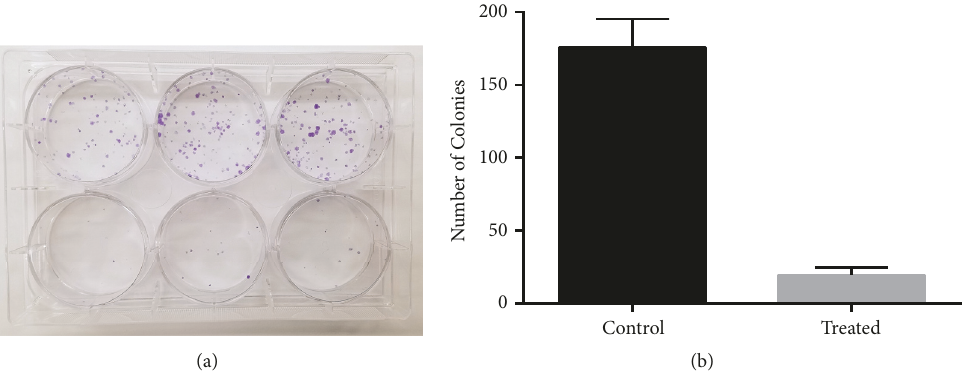
Figure 2: 4,5-diCQA decreases DU-145 cell proliferation after withdrawal of treatment . Clonogenic assays were performed to determine the long-term effects of 4,5-diCQA on DU-145 cells. The treated cells were left to proliferate for 9 days in drug-free medium. (a) Representative imageofthefixedandstainedclonogenicassaysshowingreducedcolonyformingefficiencyofthetreatedcellsonthebottomrowascompared to control on top row. (b) Colonies were counted and mean values of four trials ± standard deviations are represented. The treated group had significantly less colonies than the control ( p -value = 5.64E-06).